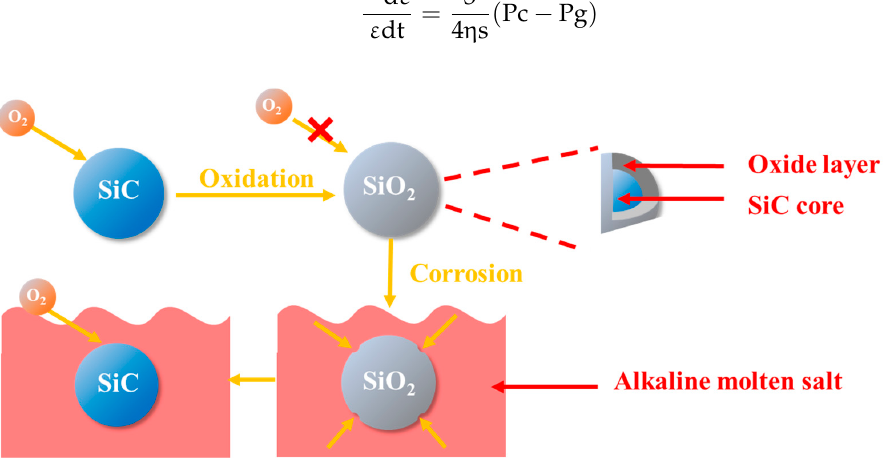
Figure 3. Schematic diagram of SiC oxidation.